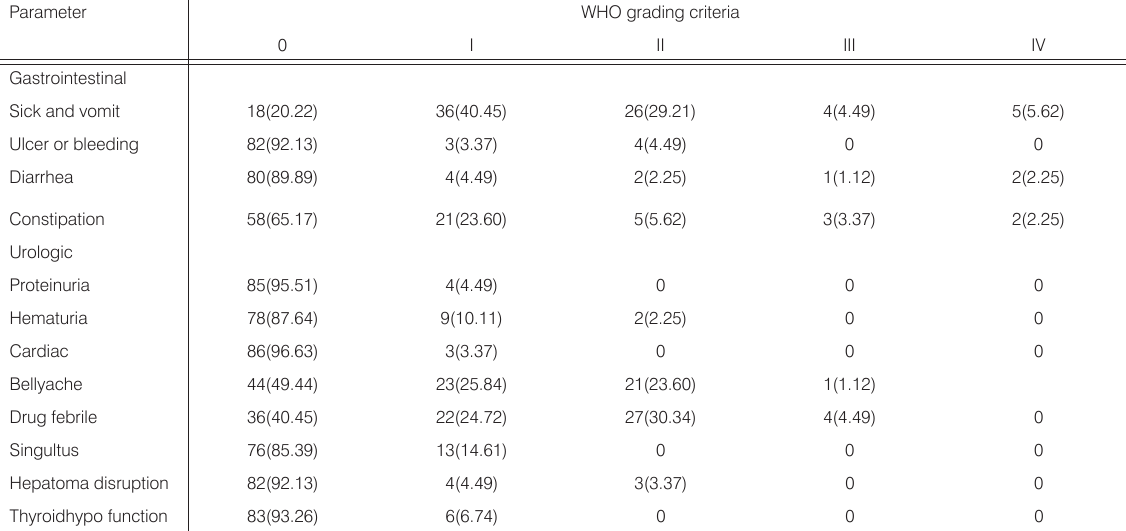
Table 1. Adverse reaction grading for 89 cases of liver cancer patients after the combined treatment of trastuzumab and TACE Parameter